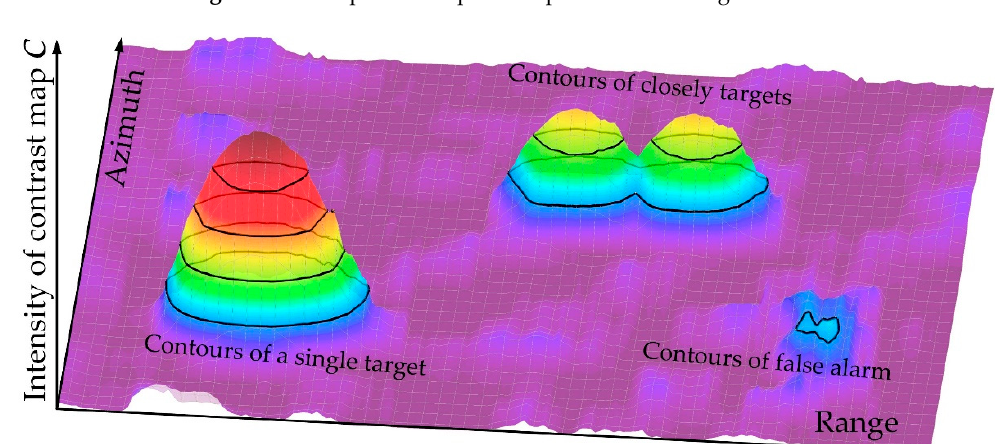
Figure 5. A sample of multiple contour tracking method.